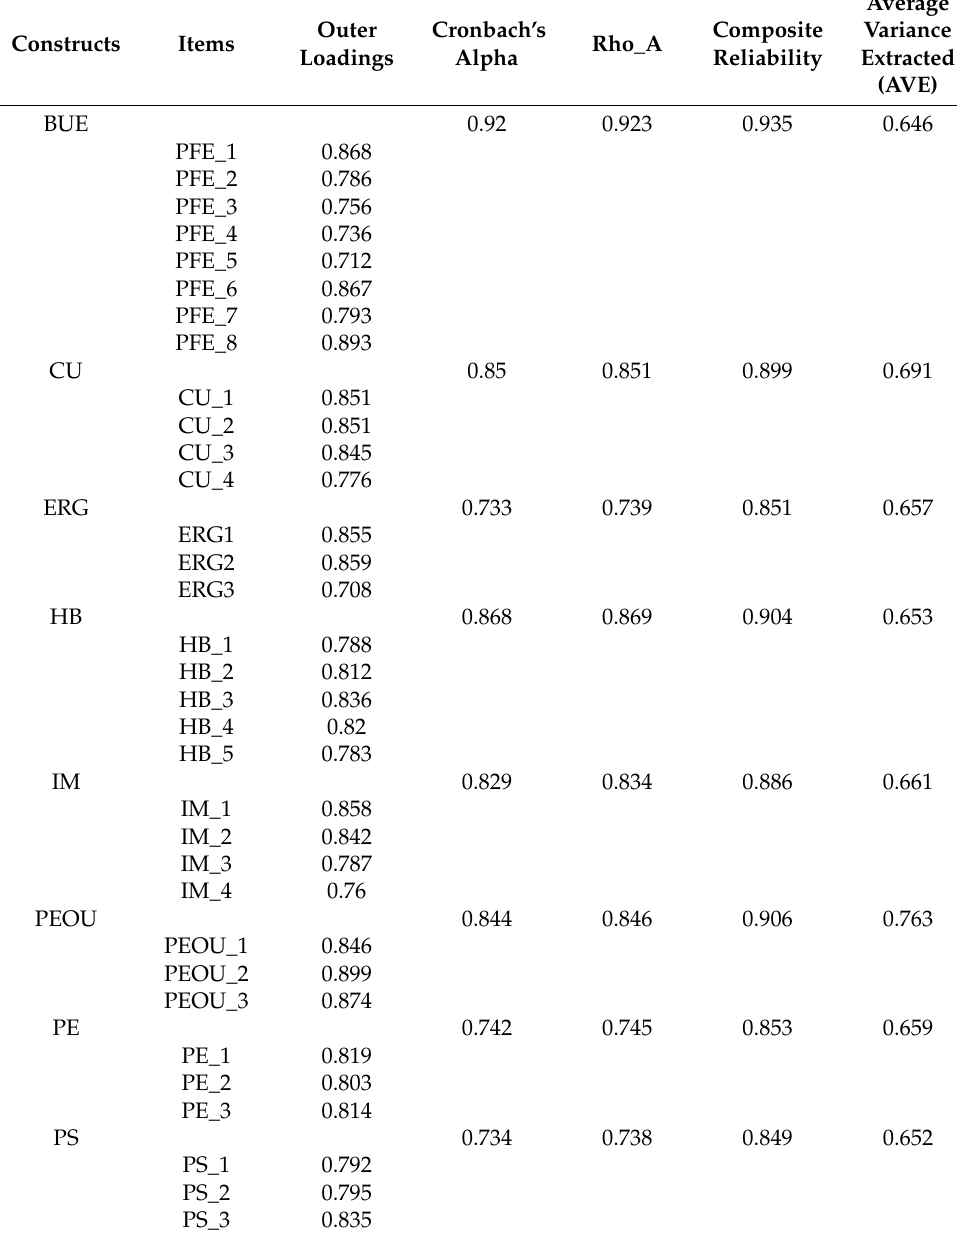
Table 2. Summary of the model